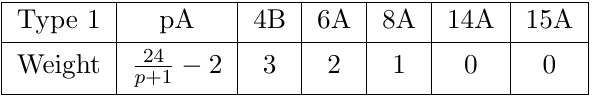
Table 2 . Weight of Siegel modular forms corresponding to classes in M 23